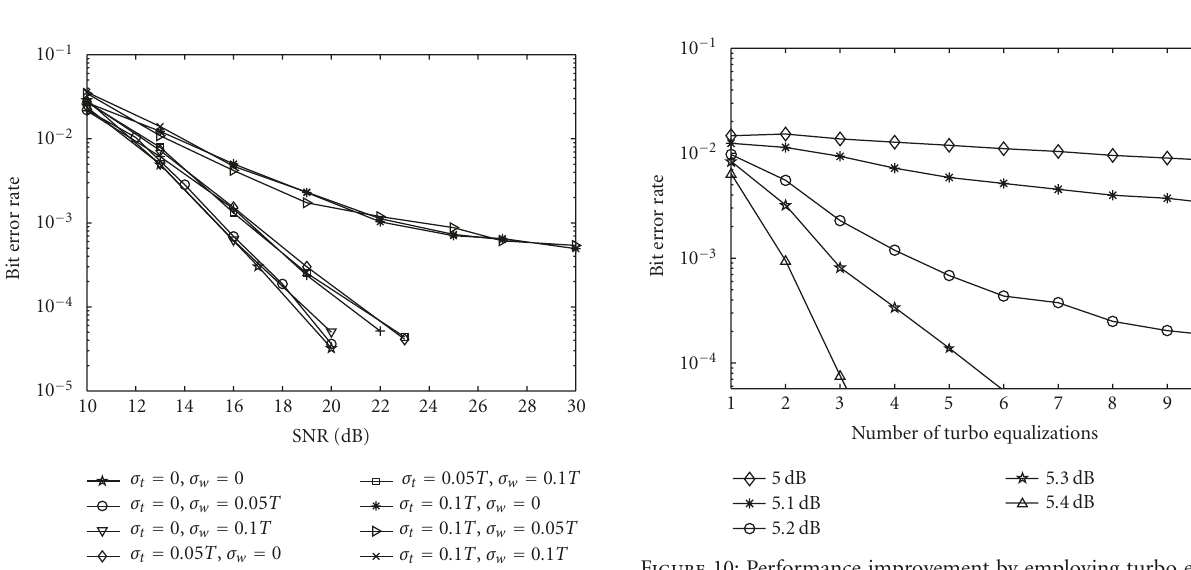
Figure 7: Performance for bit-patterned media storage system (perpendicular recording).